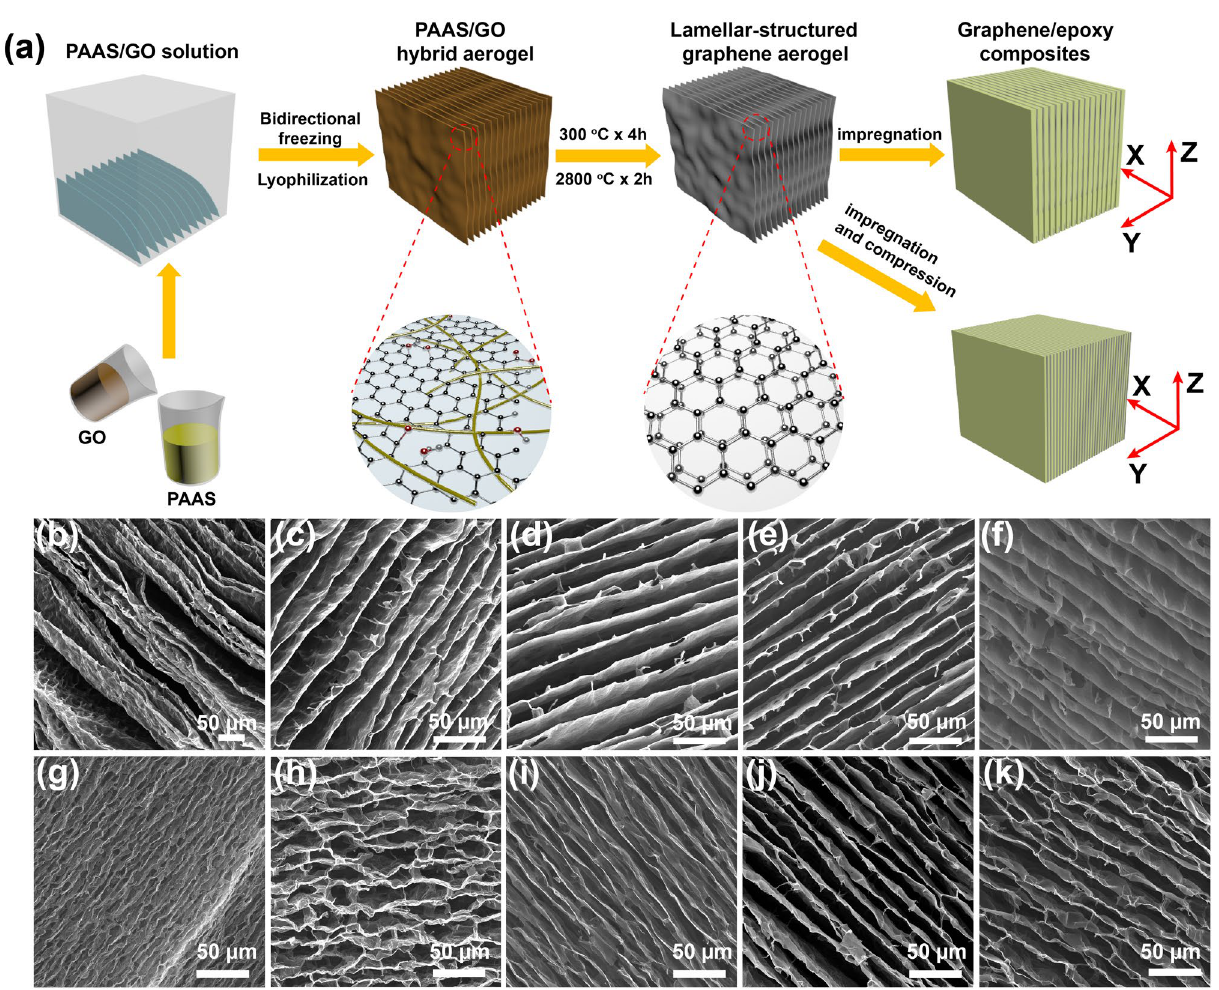
Fig. 1 a Schematic illustration of fabrication of a LSGA and its epoxy composite. SEM images of morphologies of b P9G1, c P8G2, d P7G3, e P6G4, and f P5G5 observed along Z‑axis; SEM images of morphologies of g P9G1‑2800, h P8G2‑2800, i P7G3‑2800, j P6G4‑2800, and k P5G5‑2800 observed along